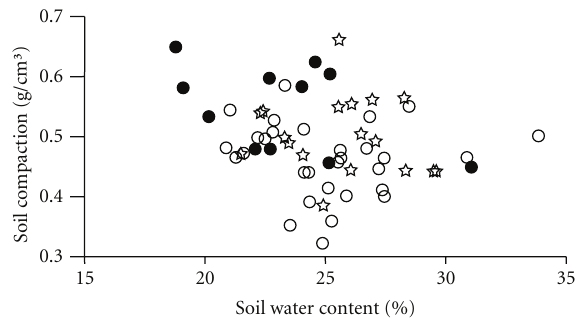
Figure 2: Soil moisture and compaction beneath of crowns the fruit trees. Open circles: guava ( Psidium guajava ); filled circles: jaboticaba ( Myrciaria jaboticaba ); stars: mango ( Mangifera indica ).